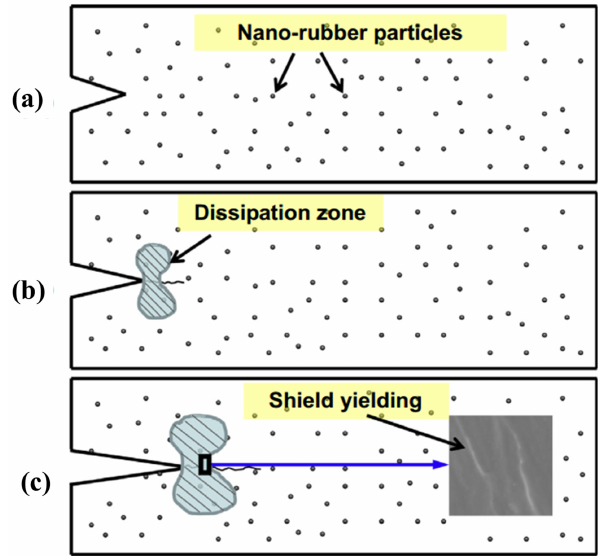
Figure 8. Schematic diagram of the stages of crack propagation in NR particles modified epoxy resins: ( a ) the notched sample, ( b ) the crack extends, ( c ) the crack propagates future. Reused with permission from Ref. [52]. Copyright 2013 Elsevier.